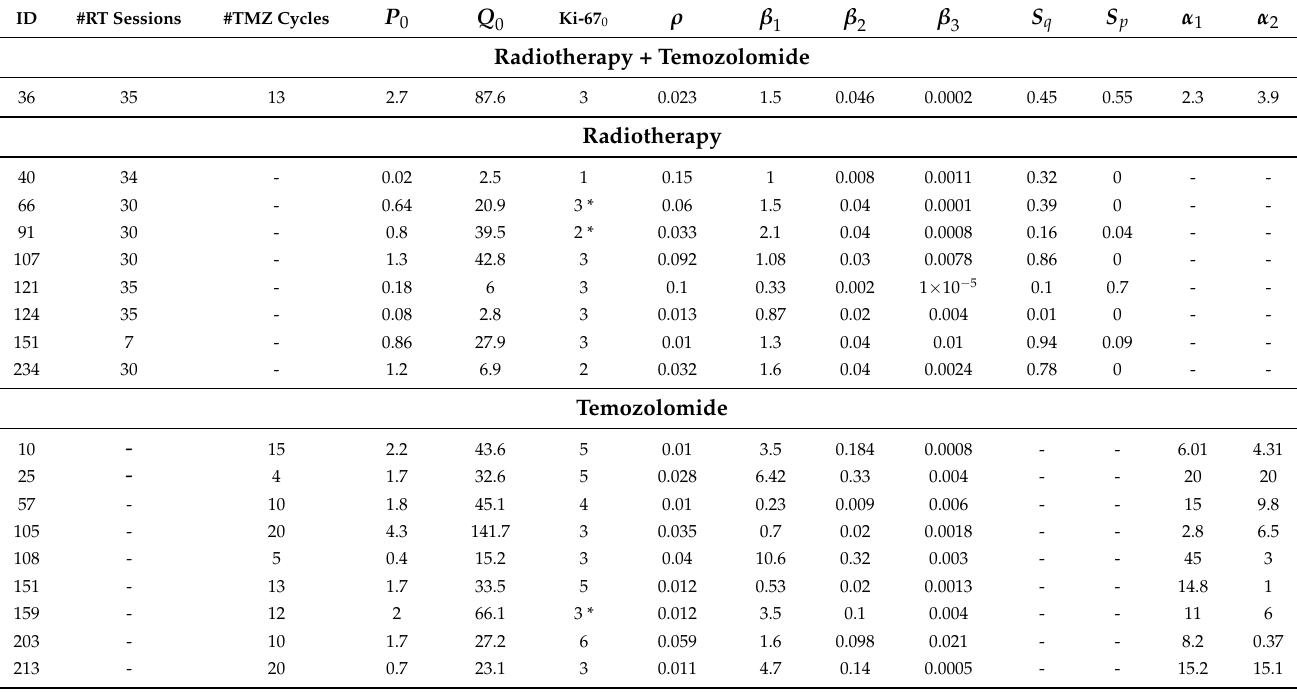
The numerical solutions of Equation (1) together with (3), (4) or (5) were computed using the Matlab function ode45 . Table 3. Parameter values obtained for the best fits of patients to Equation (1). Patient 151 was considered independently for each therapy. The units for the initial conditions and parameters are: for P 0 and Q 0 , cm 3 ; for Ki-67 0 → %; for ρ , β 1 , β 2 and β 3 , 1/day. Finally, α 1 and α 2 are measured in cm 3 / ( µ g day ) . * Estimated